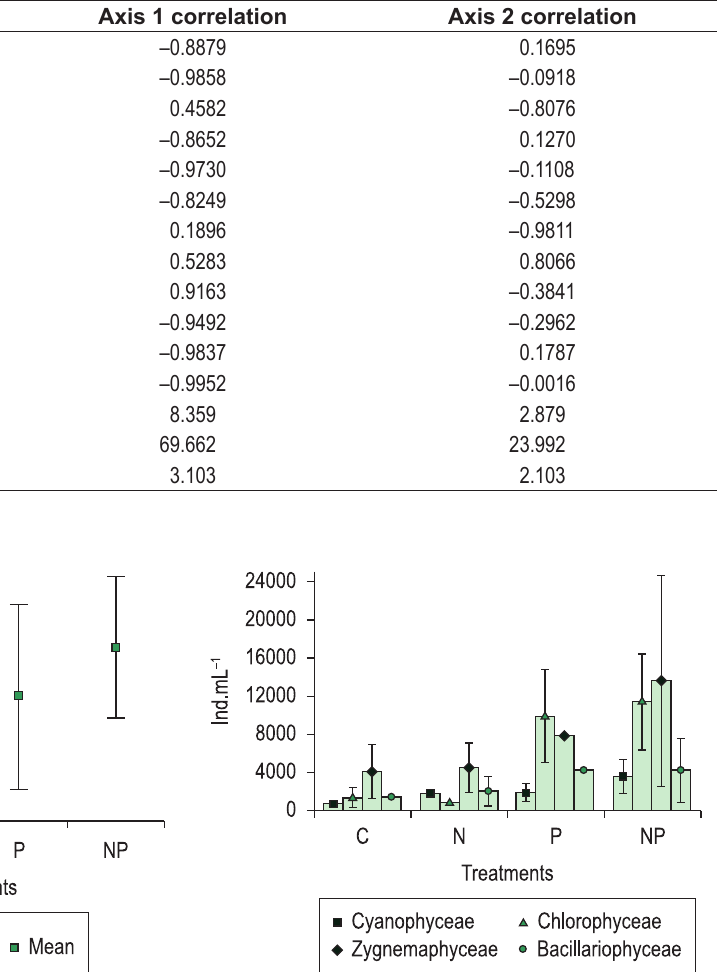
Table 2. Correlation and performance values obtained through Principal Component Analysis (PCA) to mesocosms installed in the Corvo River.